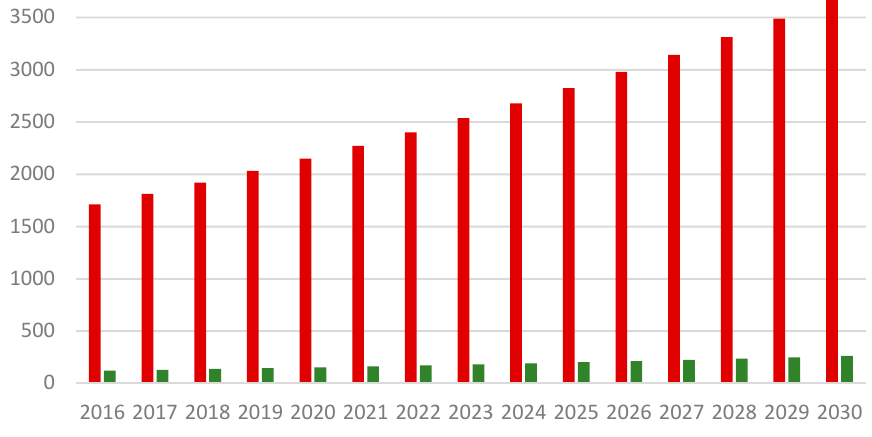
Figure 8. Total primary energy demanded under the BAU scenario (Thousands of Barrel of Oil Equivalent per year).